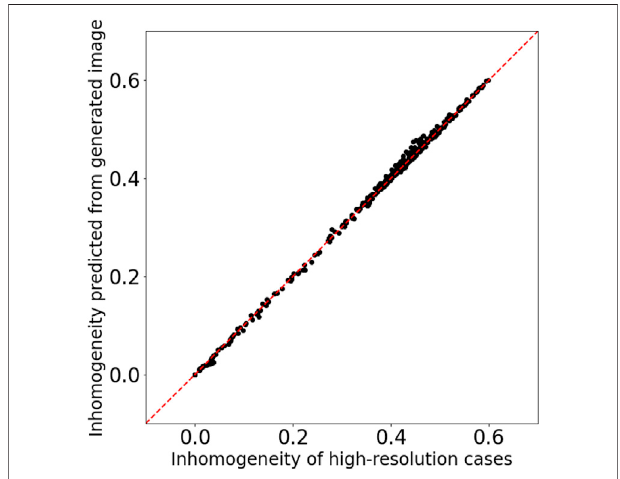
FIGURE 11 | Comparison of the inhomogeneity of the high-resolution grid simulation results and the inhomogeneity predicted from the synthesis images for the testing datasets.